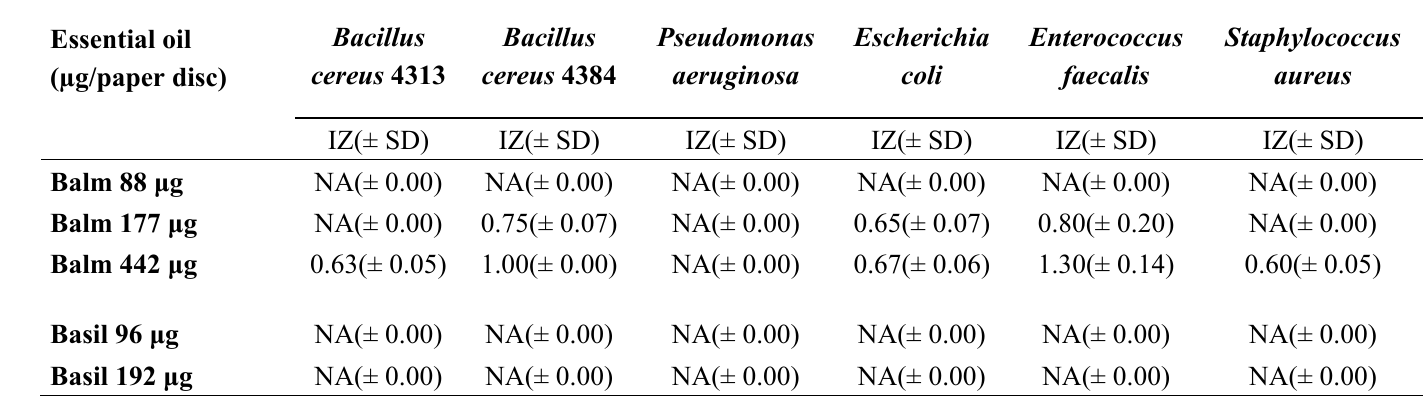
Table 2. Inhibition of bacterial growth of essential oils: Melissa officinalis L. (balm) , Ocimum basilicum L . (basil), Hyssopus officinalis L. (hyssop) , Lavandula angustifolia Mill. (lavender) , Origanum vulgare L. (oregano) , Salvia officinalis L . (sage), Thymus vulgaris L. (thyme). Data are expressed in cm and do not include the diameter of paper disc. Results are shown as mean ± standard deviation (SD) of the inhibition zone (n =